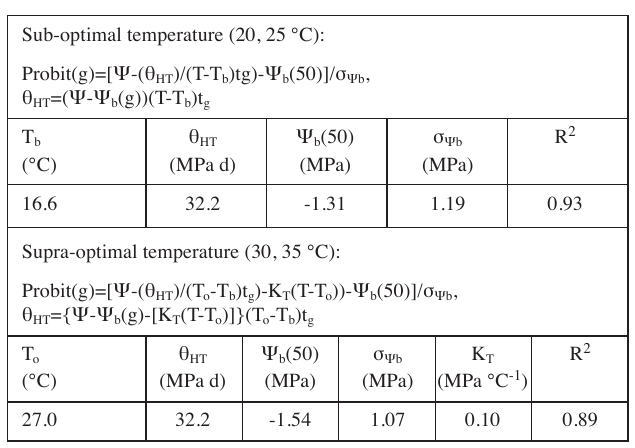
Tab. 3: Parameter estimates of the hydrothermal time model describing seed germination.